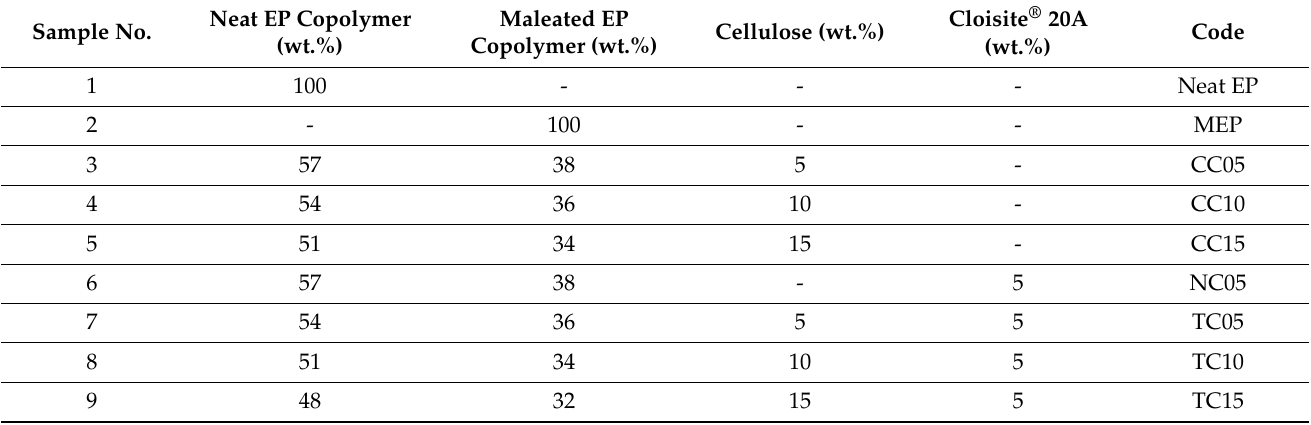
Table 5. Composition of composites prepared a .